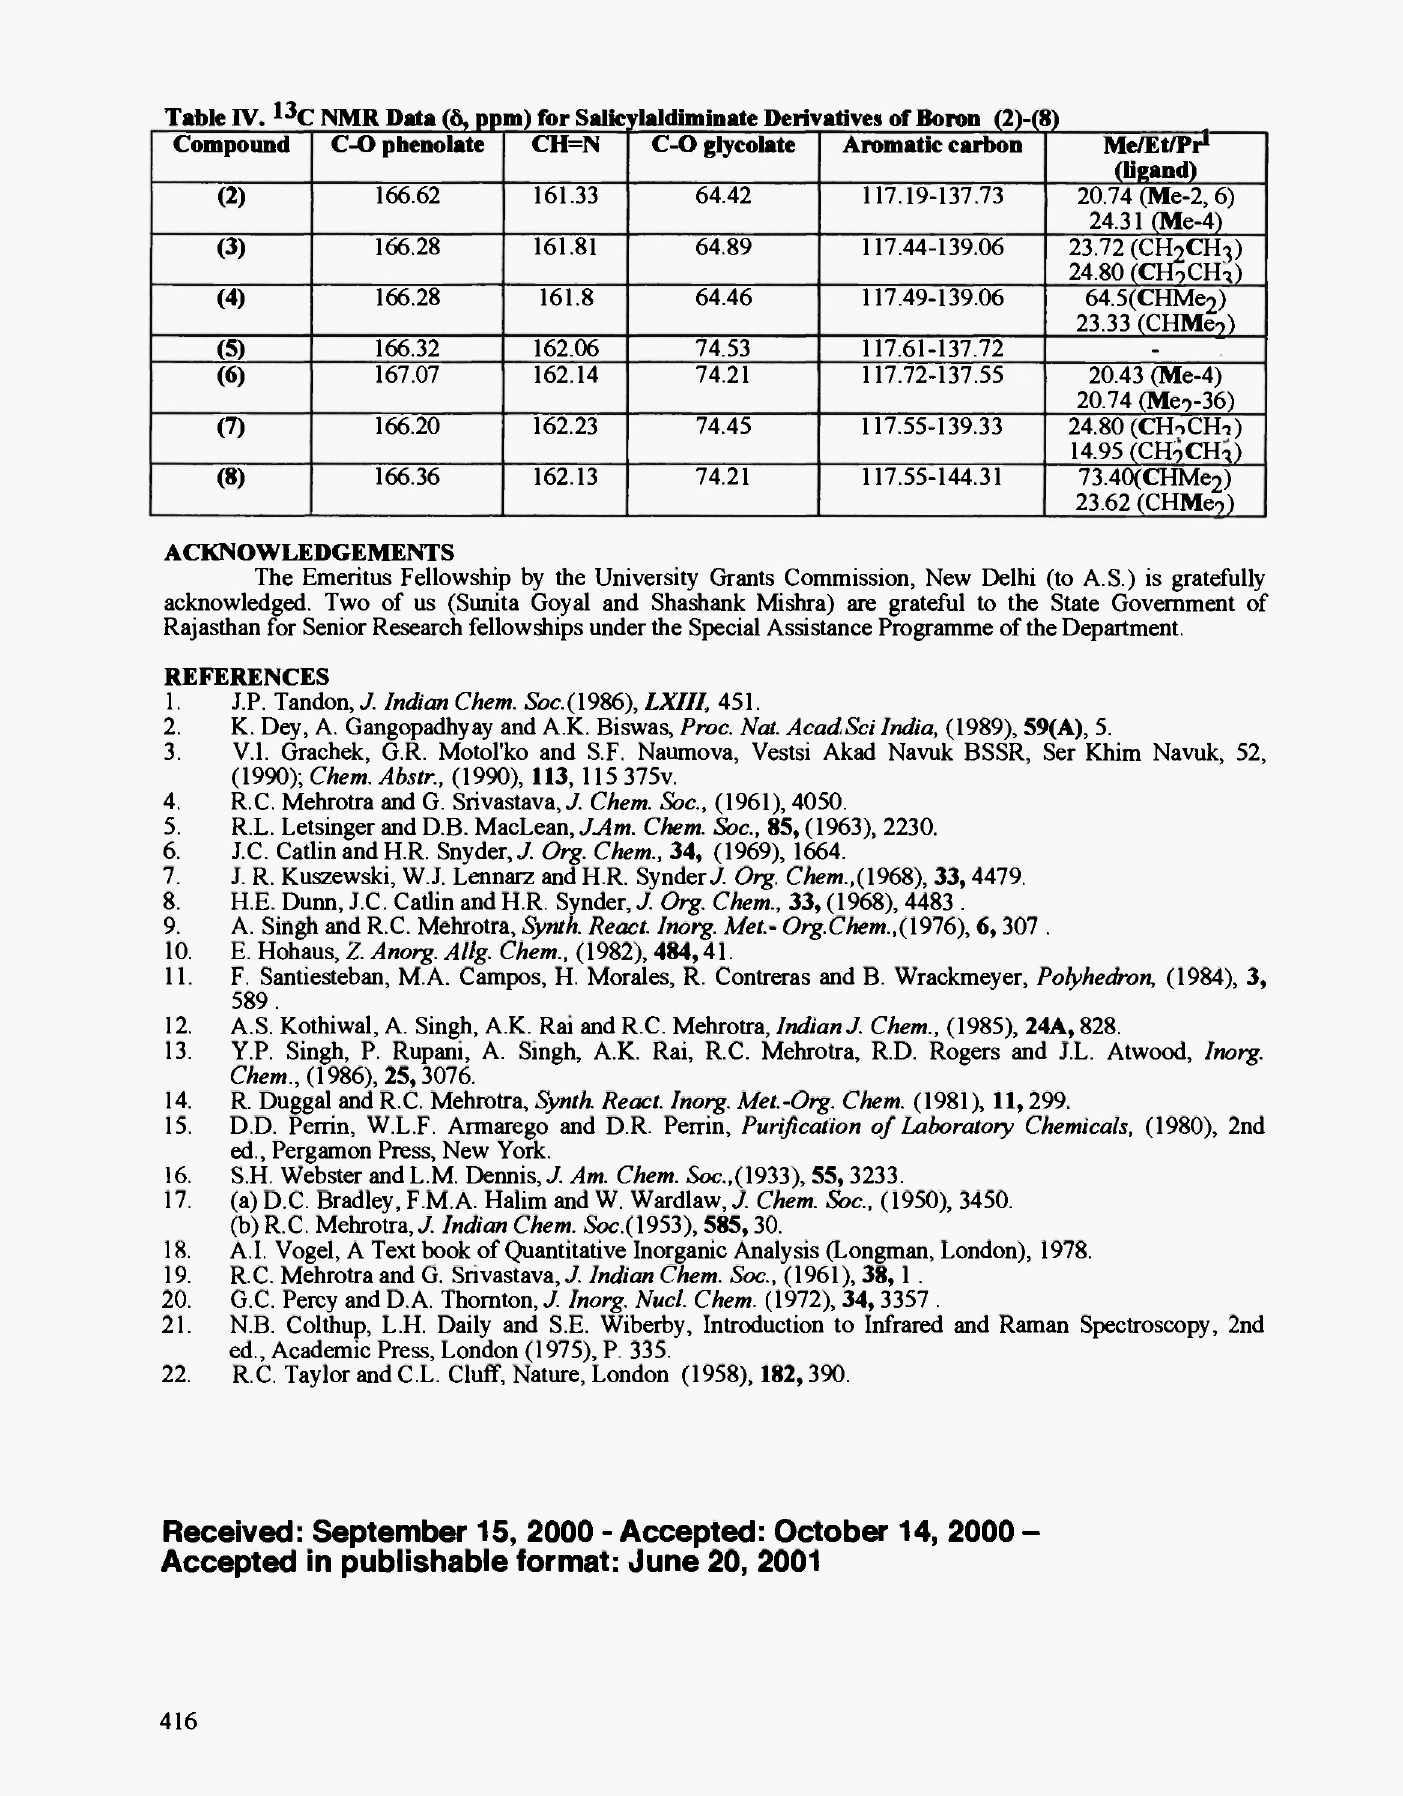
Table IV. 13 C NMR Data (6, ppm) for Salkylaldiminate Derivatives of Boron (2)-(8)